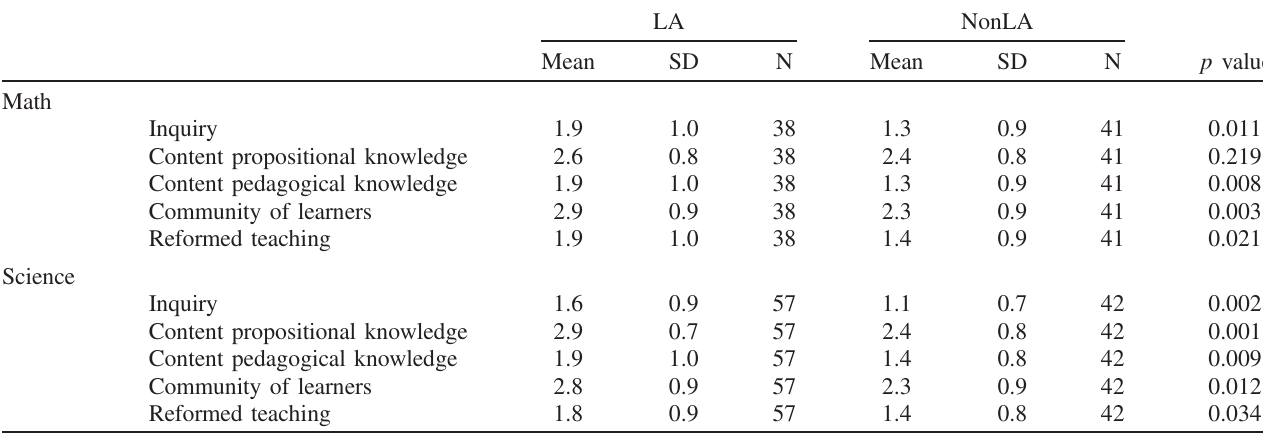
TABLE V. Average statement response for the five factors of the RTOP.